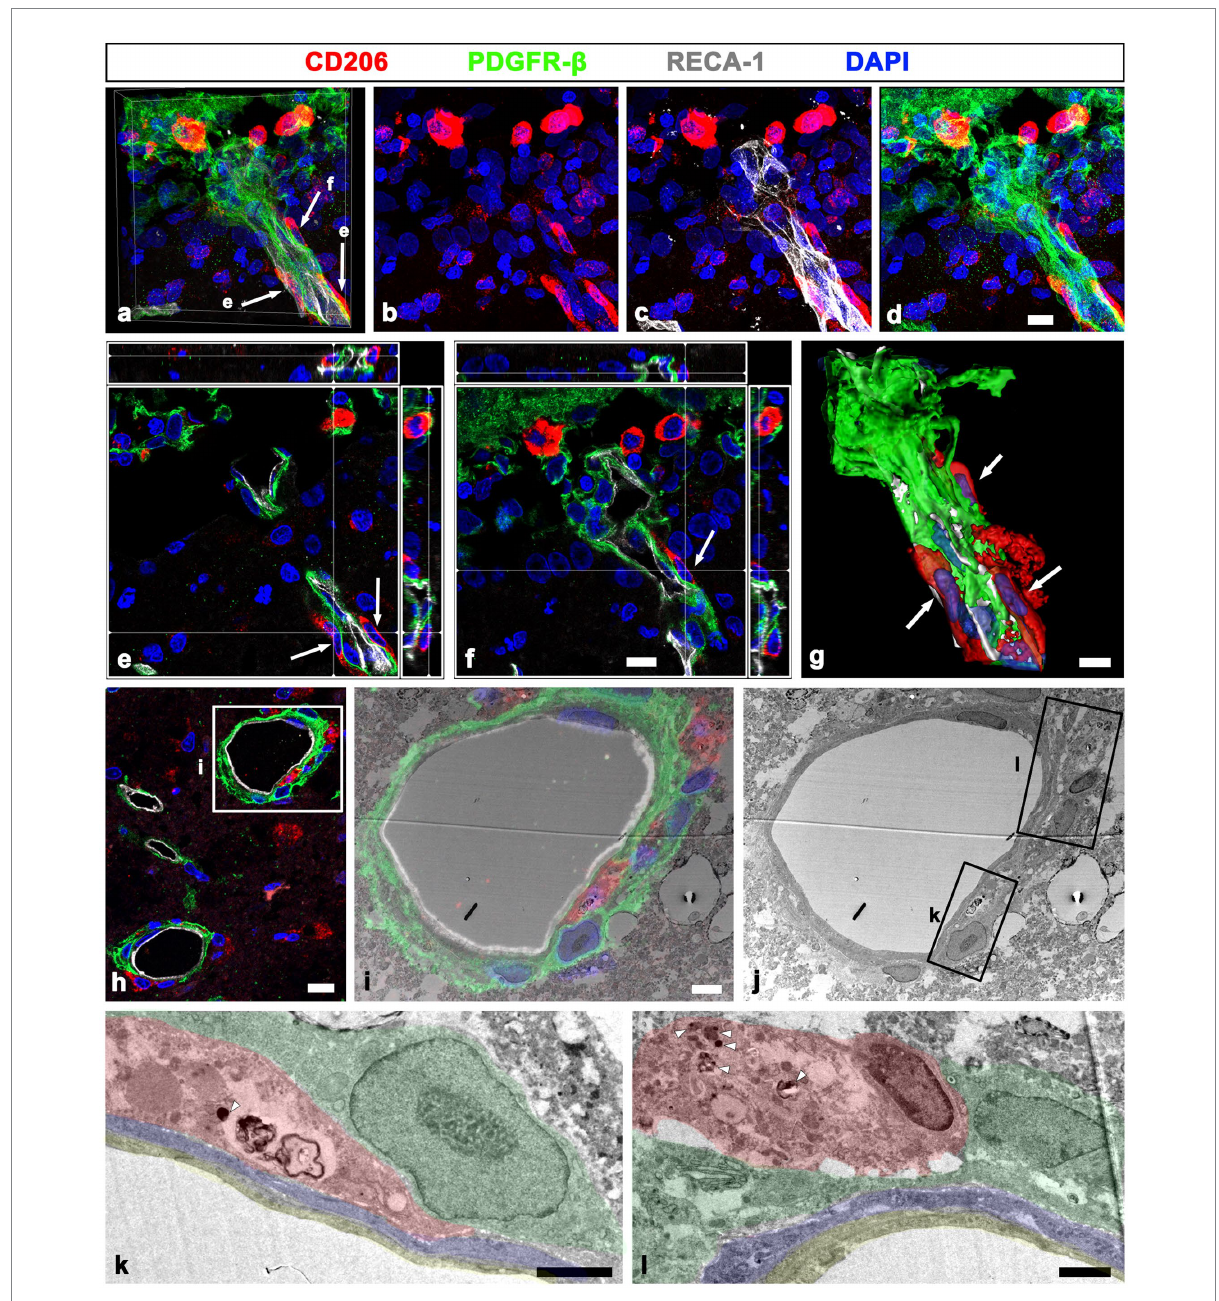
FIGURE 9 Localization of meningeal macrophages on both the adluminal and abluminal sides of PDGFR- β -positive cells related to penetrating vessels. (A–G) Triple labeling for PDGFR- β , CD206, and RECA-1 in MCAO rats at day 3 after reperfusion. (A–D) Several CD206-labeled macrophages are observed in the leptomeninges and within the cortical penetrating vessels. (E,F) Orthogonal views of three meningeal macrophages indicated by arrows in a showing that they are closely apposed to the outer part of PDGFR- β -positive cells within cortical penetrating vessels. (G) Three-dimensional magnified images showing that these meningeal macrophages (arrows) associated with penetrating vessels are localized on the abluminal side of PDGFR- β -positive cells. (H–J) Confocal microscopic image of a semi-thin section triple labeled with CD206, PDGFR- β , and RECA-1 (H) ; of a boxed area overlaid onto the corresponding electron microscopic image (I) ; and the corresponding transmission electron microscopic image obtained from the same field (J) . (K,L) Higher magnification views of the boxed areas in (J) showing that meningeal macrophages (shaded in red) containing secondary lysosomes (arrowheads in K and L ) are localized not only between smooth muscle cells (shaded in blue) and PDGFR- β - positive cells (shaded in green), but also in close contact with the abluminal surface of PDGFR- β -positive cells. Endothelial cells are shaded in orange. Scale bar = 10 μ m for (A-F) , 5 μ m for (G) , 4 μ m for (I-J) , and 2 μ m for (K-L)